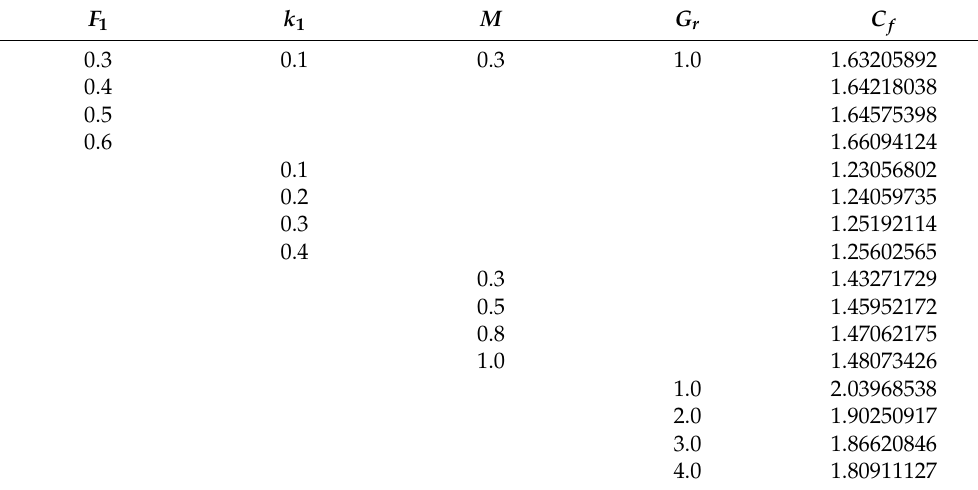
Table 2. Numerical outcomes of C f for k 1 , M , G r , and F 1 .